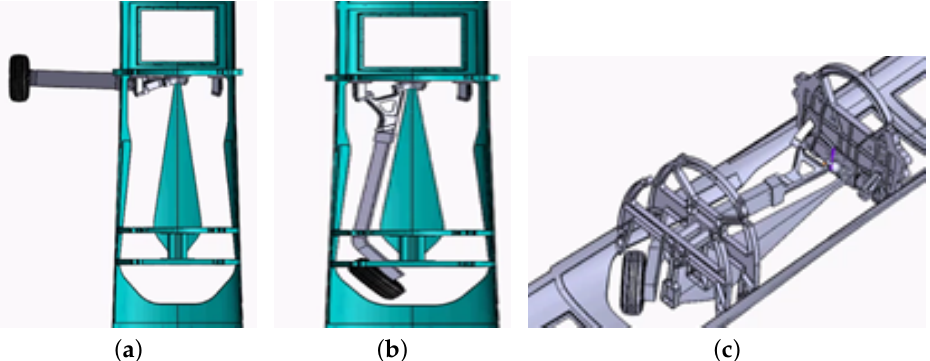
Figure 13. Collision detection test for retraction clearance of landing gear strut. ( a ) At start of retraction test. ( b ) On completion of retraction test. ( c ) Isometric view of retractable main landing gear